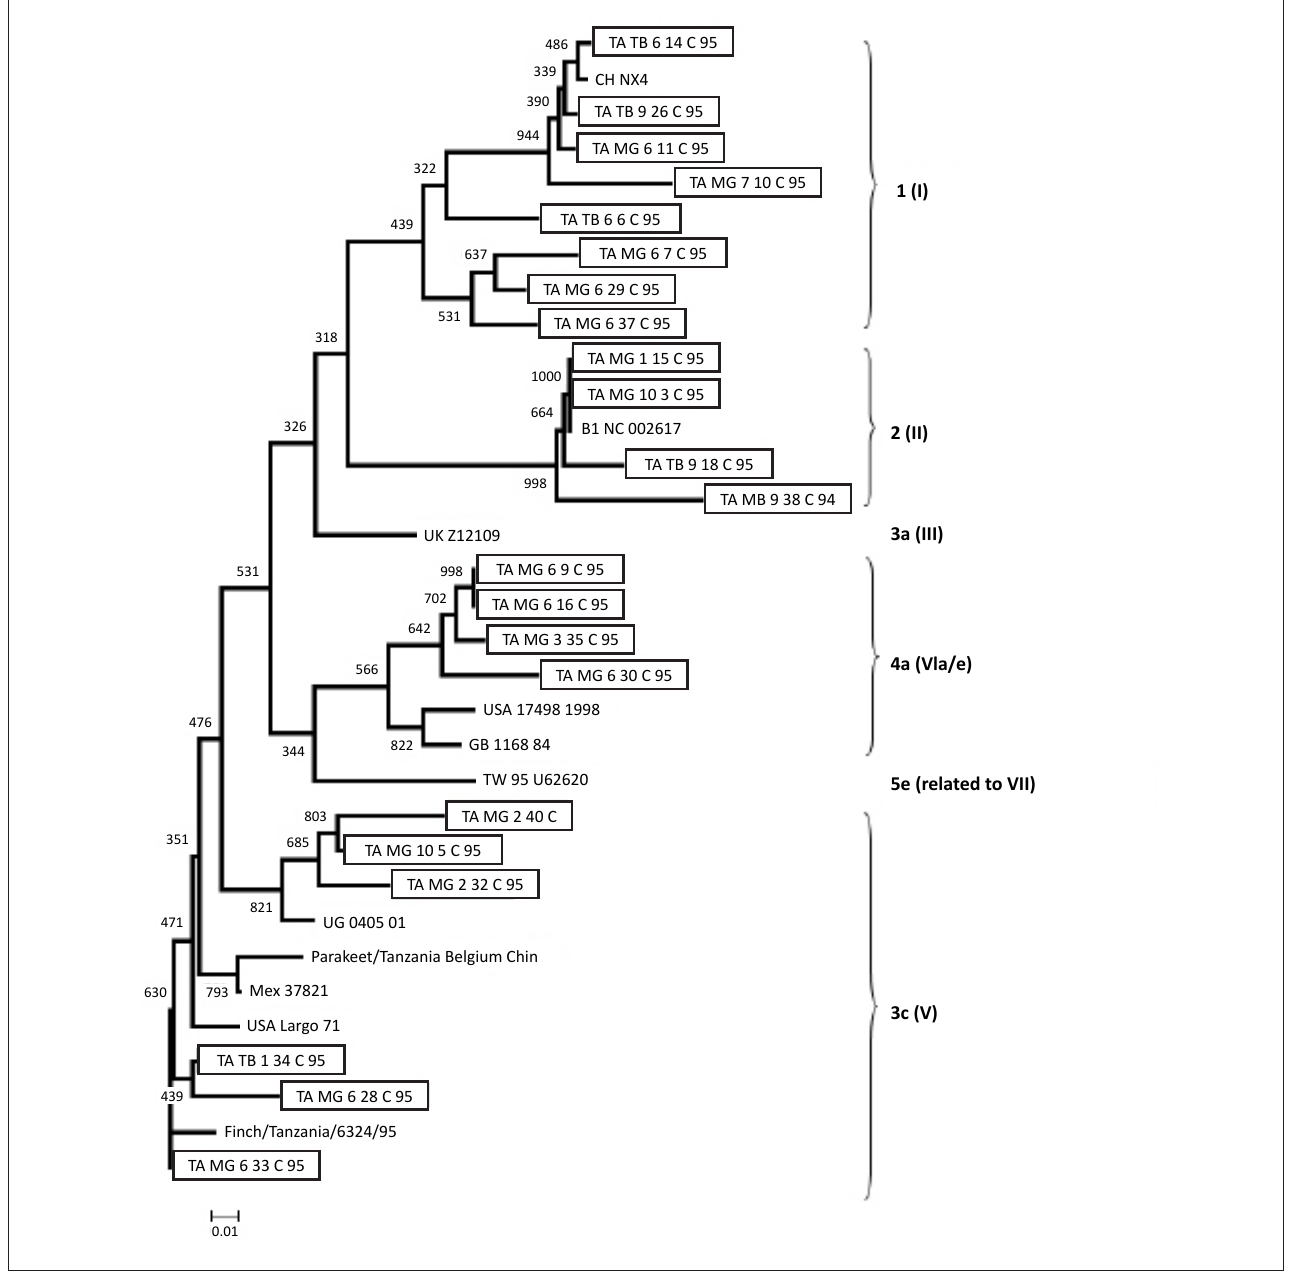
FIGURE 2: Neighbour-joining-based phylogeny of Newcastle disease virus isolates from Tanzania with reference to published genotypes based on partial nucleotide sequence comparison of the F